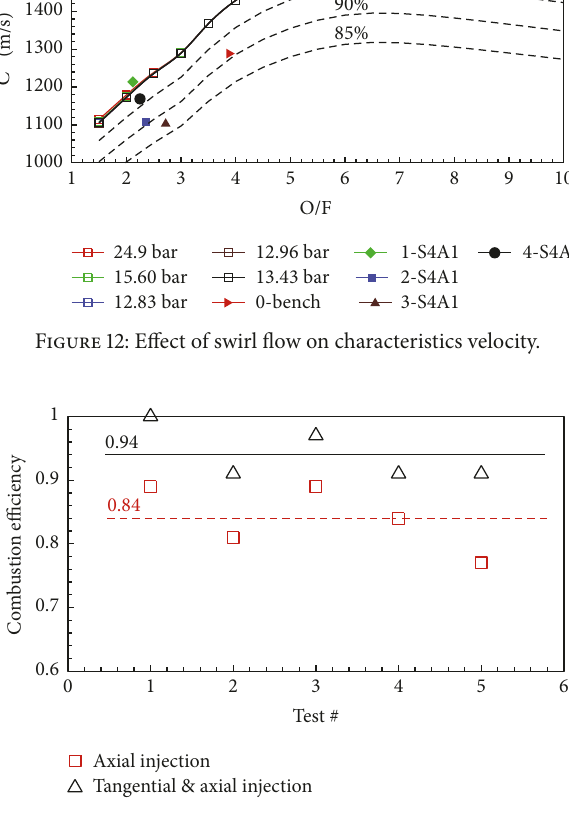
Figure 13: Comparison of combustion efficiency for oxidizer swirl flow and axial